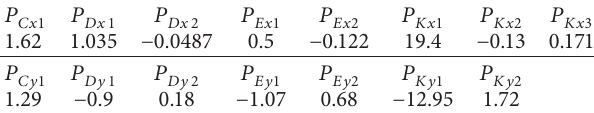
Table 3: Fitting parameters of the “Magic Formula”